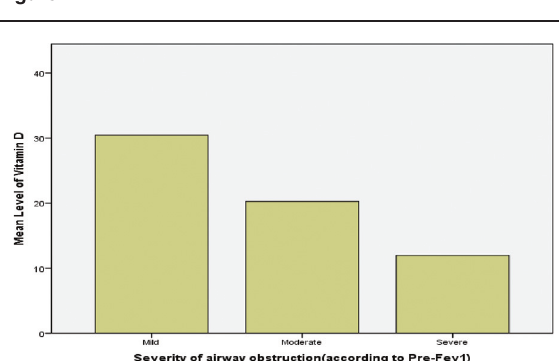
Relation between Severity of Asthma (According to Pre-FEV 1 ) and Vitamin